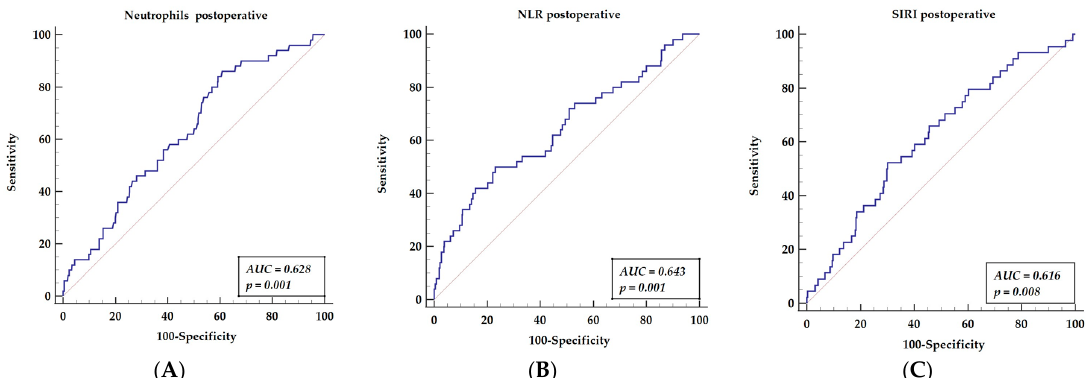
Figure 2. Receiver operator characteristics curves of three hematologic indices related to neutrophils-neutrophil counts ( A ), NLR ( B ), SIRI ( C ) that are significant for mortality prediction in multivariable analysis. Abbreviations: NLR—neutrophil to lymphocyte ratio, SIRI—systemic inflammatory response index.